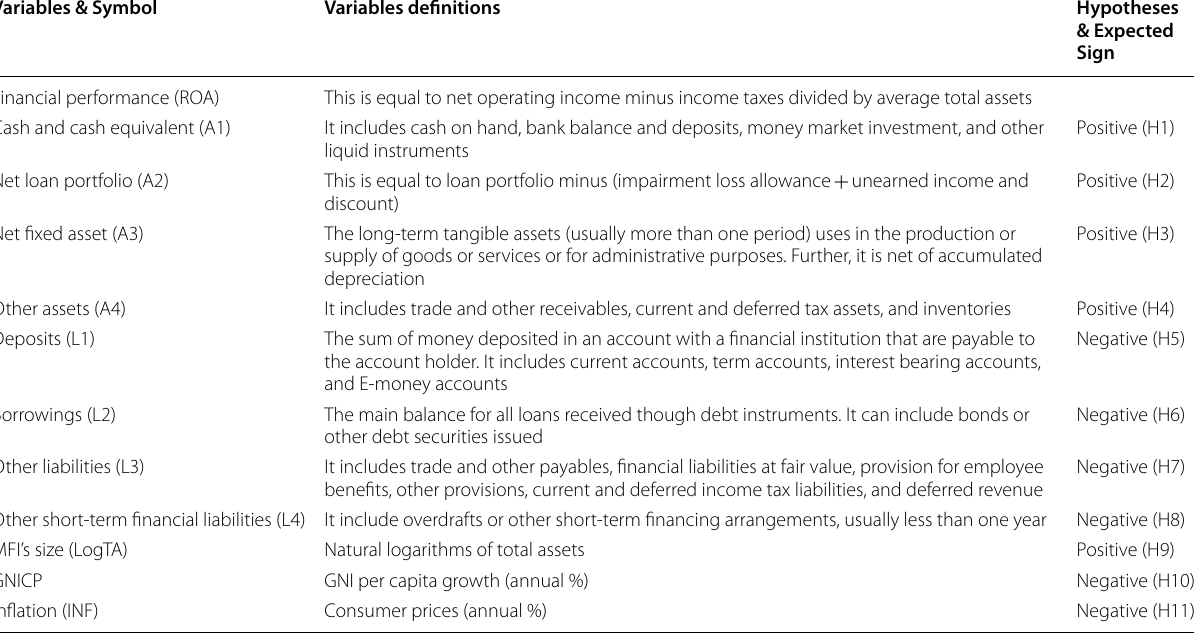
Table 1 Definitions of variables, hypotheses and expectation. Source Empirical Studies & MIX